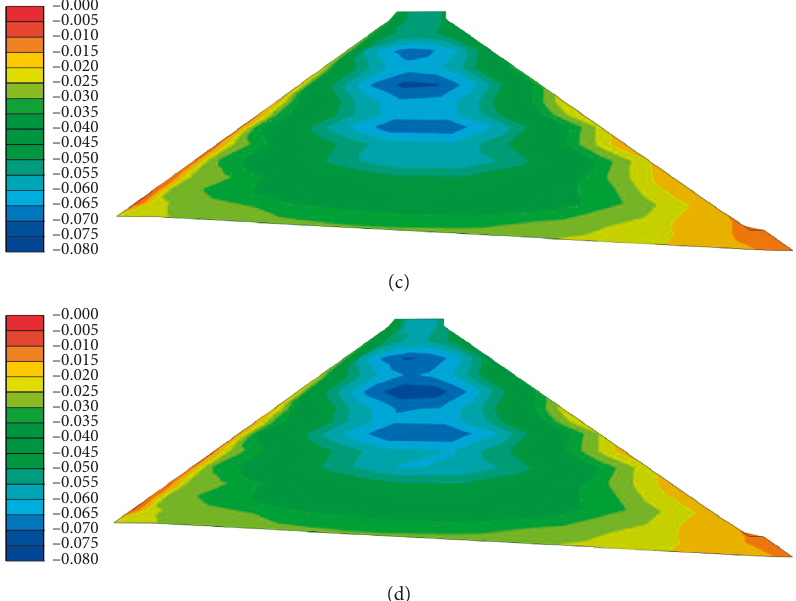
Figure 16: Settlement distributions in section B-B on typical days (m): (a) 1000 days, (b) 2000 days, (c) 3000 days, and (d) 4000 days.